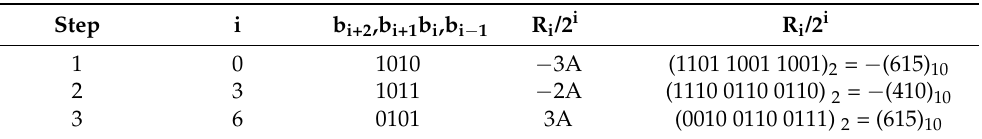
Table 3. Multiplication of two arguments A = (11001101) 2 and B = (10101101) 2 according to the proposed